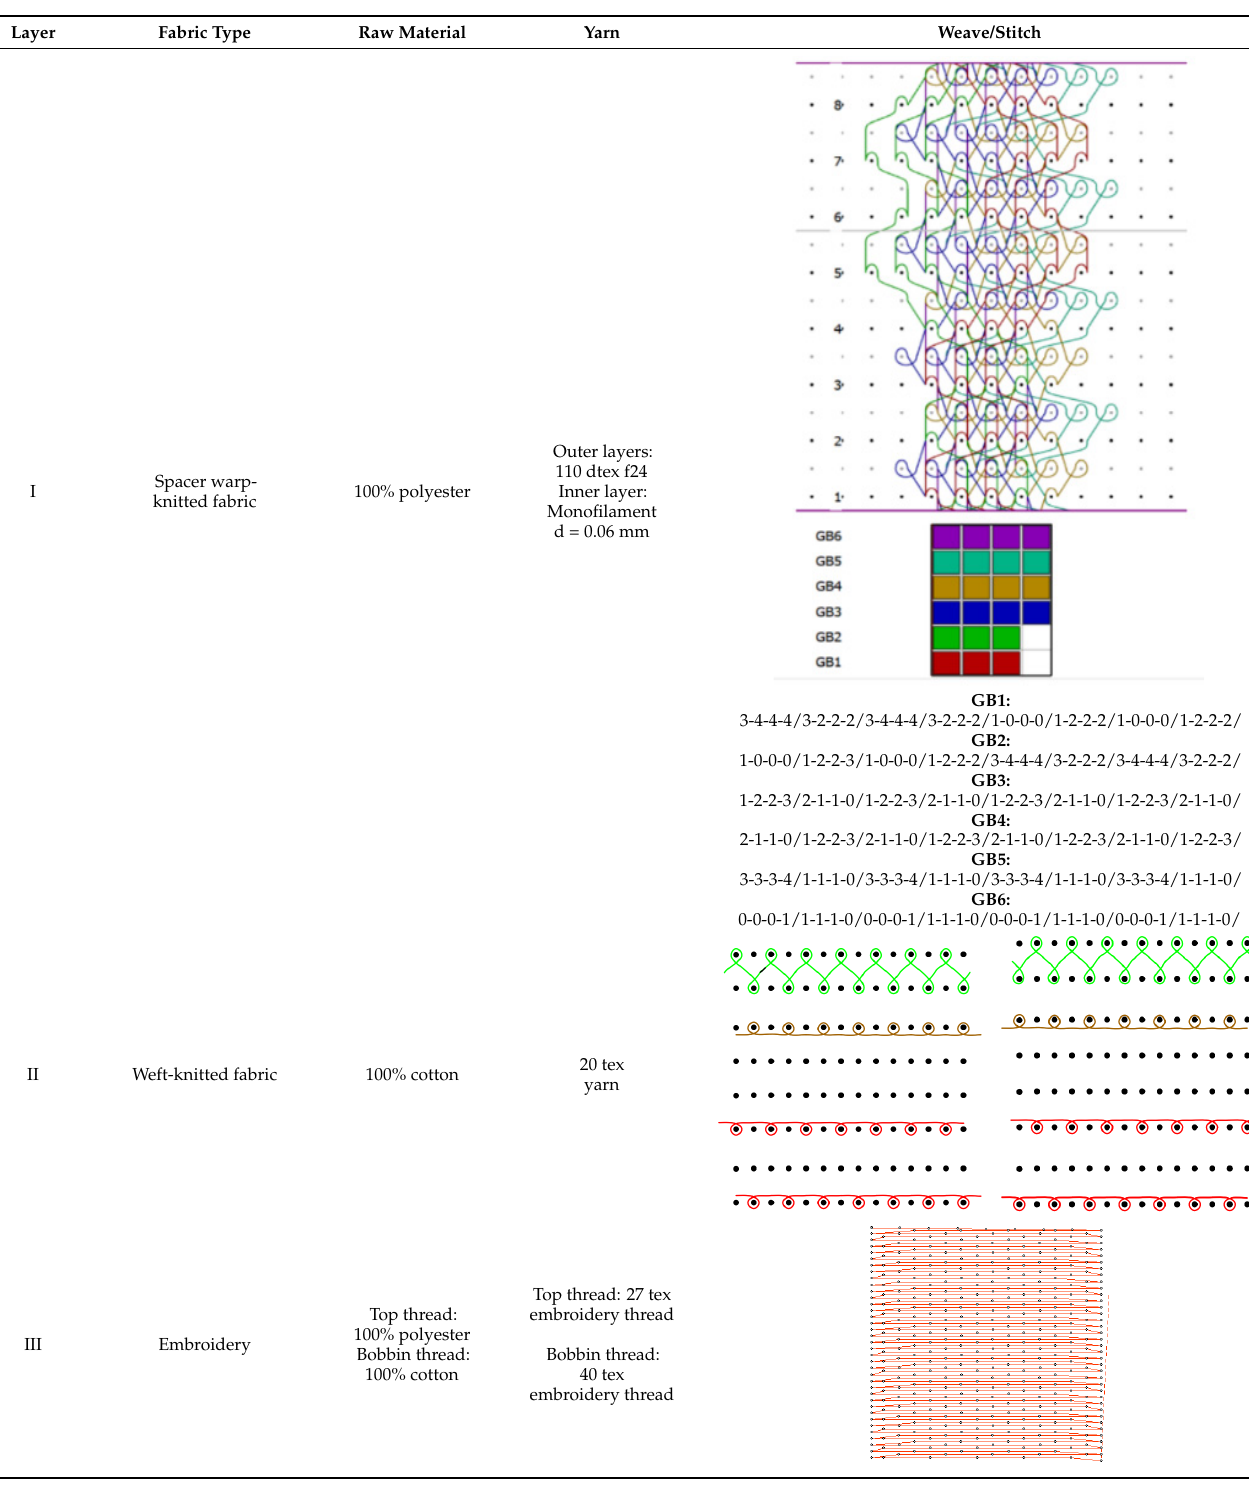
The basic structural parameters determined for the knitted fabrics used in the foot- wear are summarized in Table 2. Table 2. The characteristics of the knitted fabrics.